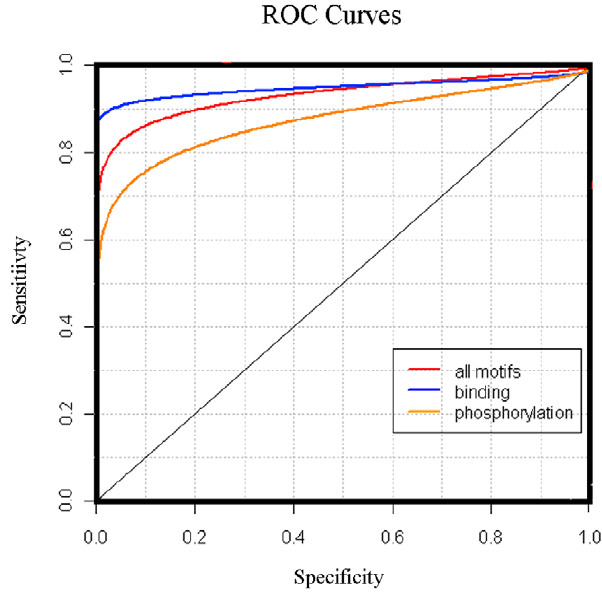
Figure 1. ROC curves for the GI filter with different types of minimotifs. ROC curves are generated using R software package with activity and sub-activity as the underlying variables. The binomial curve fit is shown. The areas under the ROC curves are 0.93 for all minimotifs (red lines), 0.95 for binding motifs (blue lines) and 0.87 for phosphorylation minimotifs (orange lines).